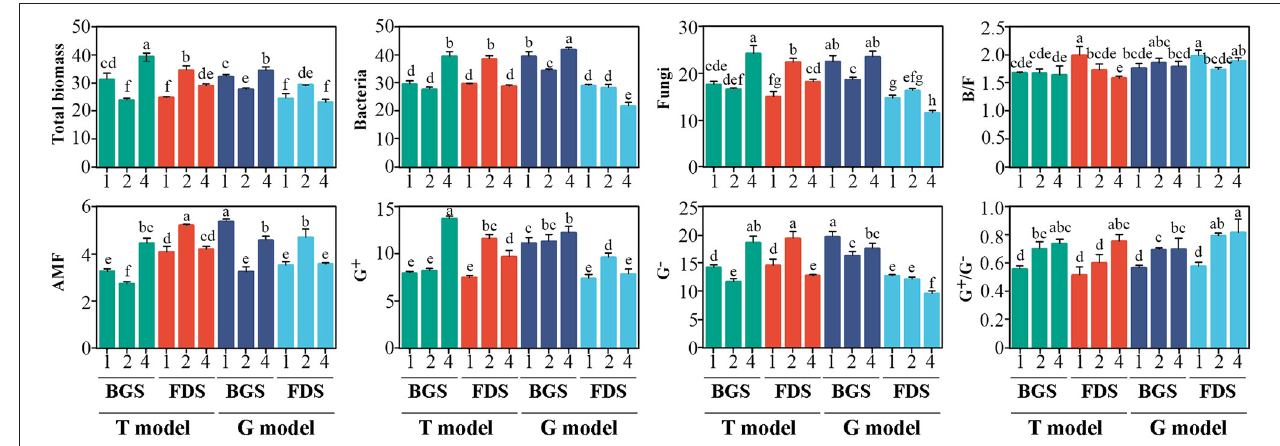
FIGURE 1 | Variation in soil microbial PLFAs between the intercropping patterns and between the development stages in the studied soils. B/F, bacterial biomass/fungal biomass ratio; AMF, arbuscular mycorrhizal fungi; G + , gram-positive bacteria; G − , gram-negative bacteria; G + /G − , gram-positive bacteria/gram-negative bacteria ratio. 1, 2, and 4 indicate intercropping with 0, 1, and 3 species of aromatic plants, respectively, to facilitate regression analysis. BGS, branch growth stage; FDS, fruit development stage. T model, intercropping with aromatic plants in the clean tillage soil; G model, intercropping with aromatic plants in the natural grass soil. Different letters indicate significant differences at P < 0.05 based on Duncan’s multiple range